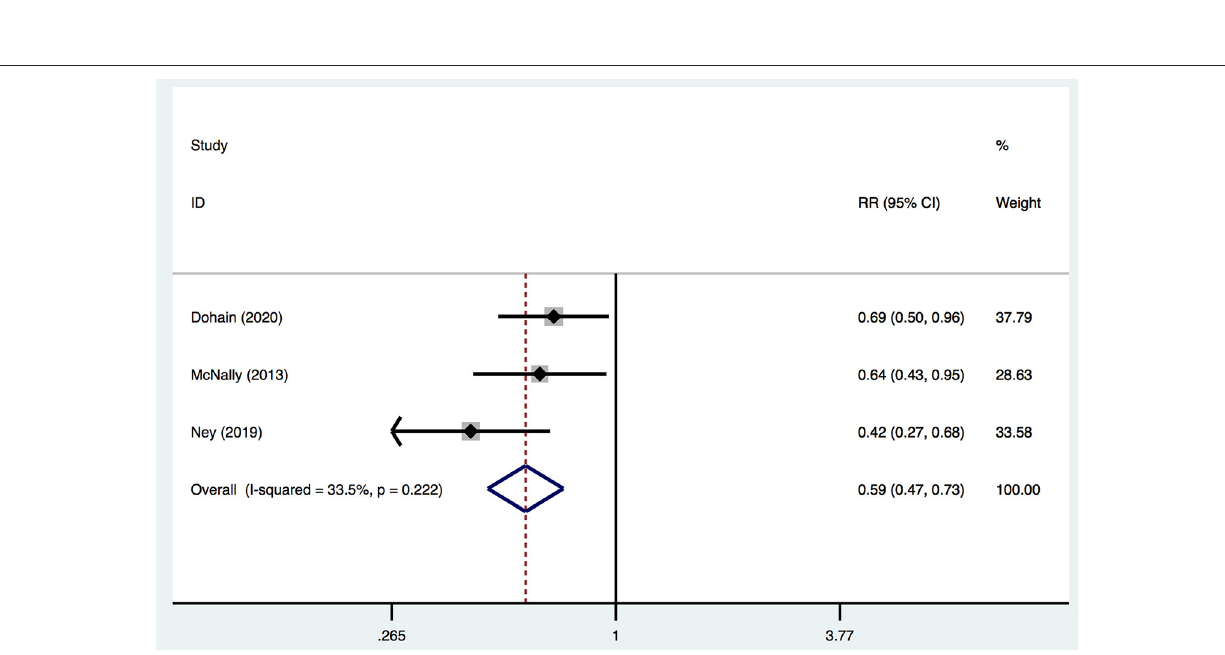
Frontiers in Cardiovascular Medicine |